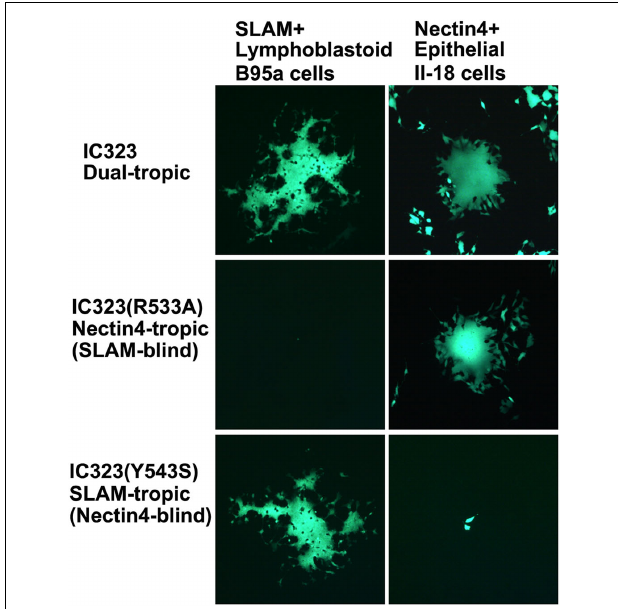
FIGURE 2 | Dual-tropic nature of wt MV. Wt MV (IC323) infects and produces syncytia in both SLAM-positive lymphoblastoid B95a and nectin4-positive epithelial II-18 cells (dual-tropic). IC323 with an R533A mutation in the H protein fails to spread in B95a cells (SLAM-blind), but replicates well in II-18 cells (nectin4-tropic). On the contrary, IC323 with a Y543S mutation in the H protein spreads in B95a cells (SLAM-tropic), but fails to spread in II-18 cells (nectin4-blind). All MVs in this figure are engineered to express